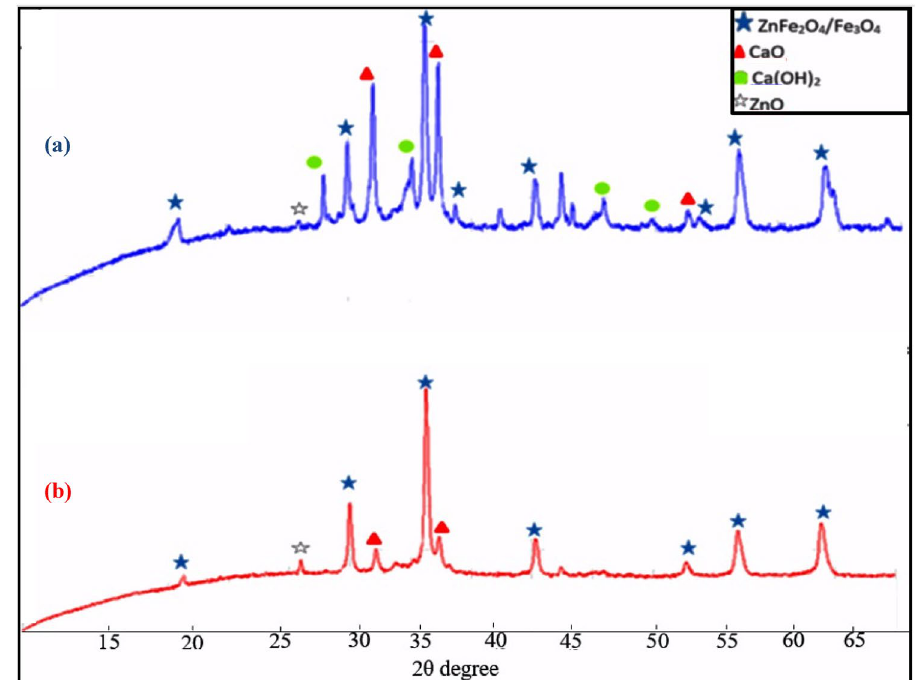
Figure 4. XRD patterns of EAFD ( a ) and 2% v/v acetic acid-treated EAFD ( b ).